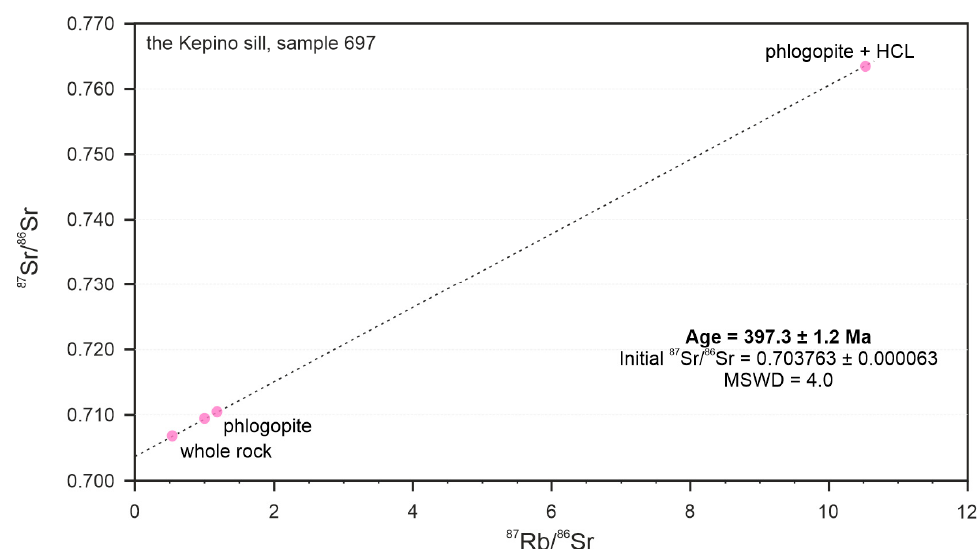
Figure 13. Rb–Sr isochron diagram for phlogopite and whole-rock fractions from sill 697.